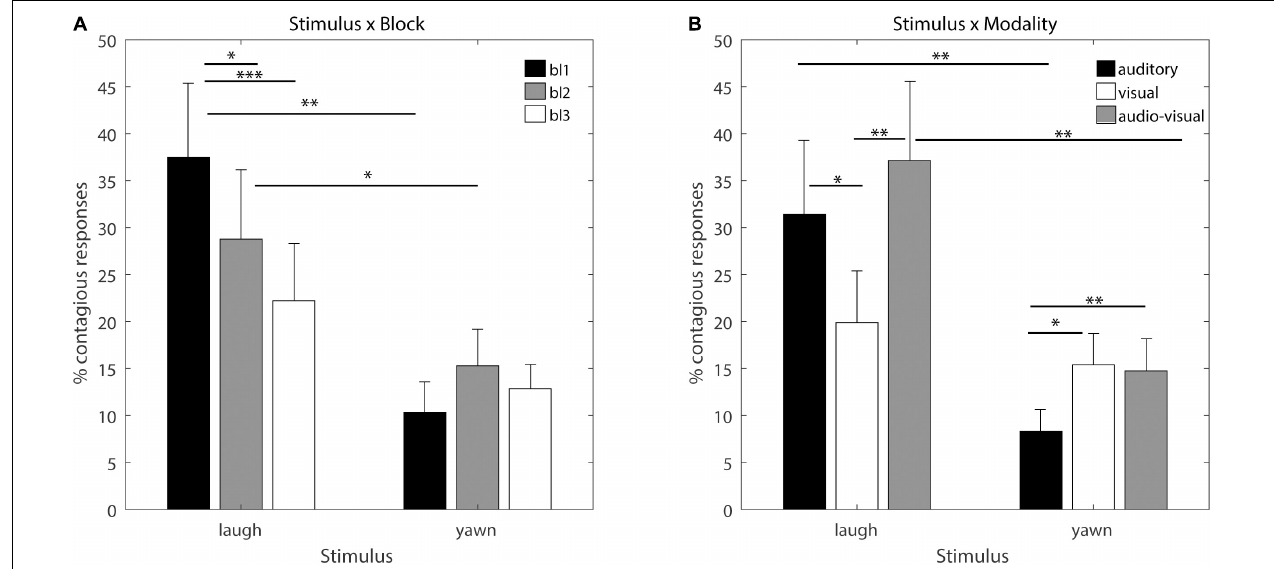
FIGURE 2 | Significant interactions. The y axis denotes the overall percentage of contagious responses, bars denote marginal means for each condition and error bars denote standard errors. Significant linear contrasts (FDR corrected for multiple comparisons) are indicated by asterisks ( ∗ p < 0.05, ∗∗ p < 0.01, and ∗∗∗ p < 0.001). (A) Interaction between Stimulus × Block: contagious responses for laughter and yawning in the 1st (black bars) 2nd (gray bars) and 3rd (white bars) block. (B) Interaction between Stimulus × Block: contagious responses in the auditory (black bars), visual (white bars) and audio-visual (gray bars) modality for laughter and